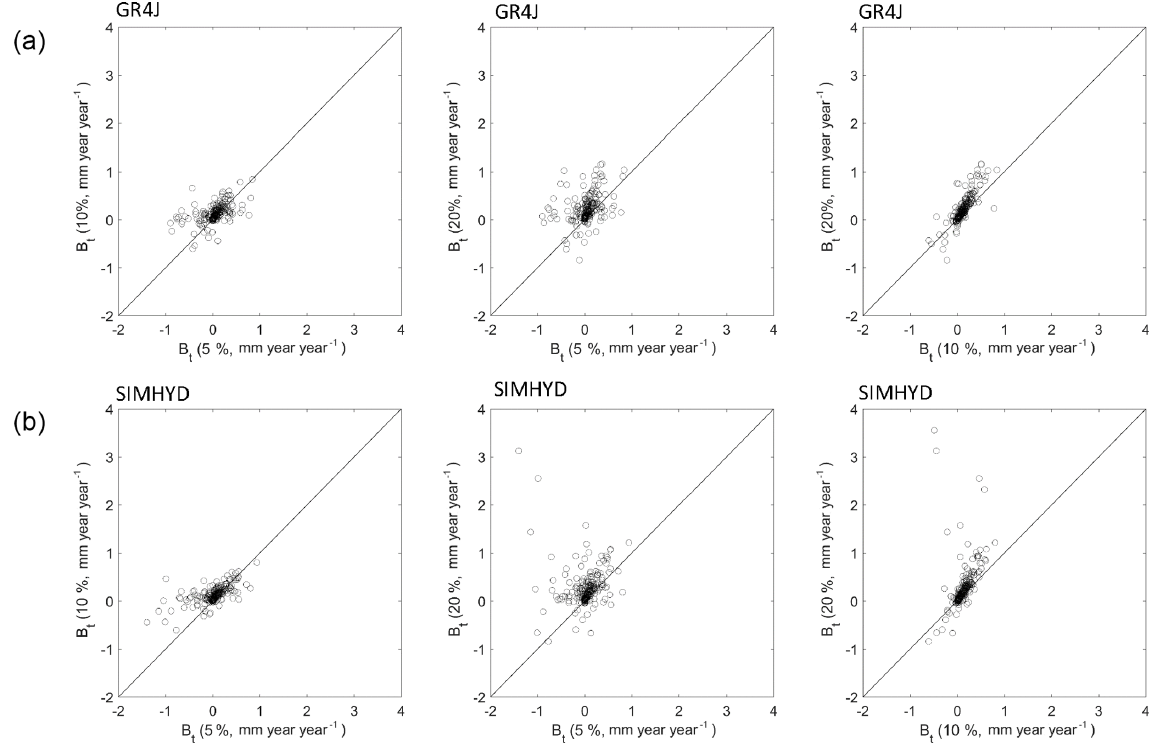
Figure 9. Trend biases comparison between the three groups of gap-filling experiments (5%, 10% and 20%). (a) is for GR4J and (b) is for